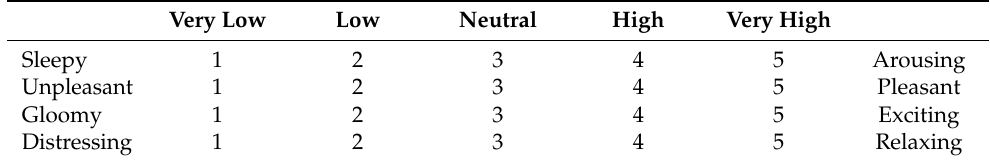
Table A2. Items for affective image.